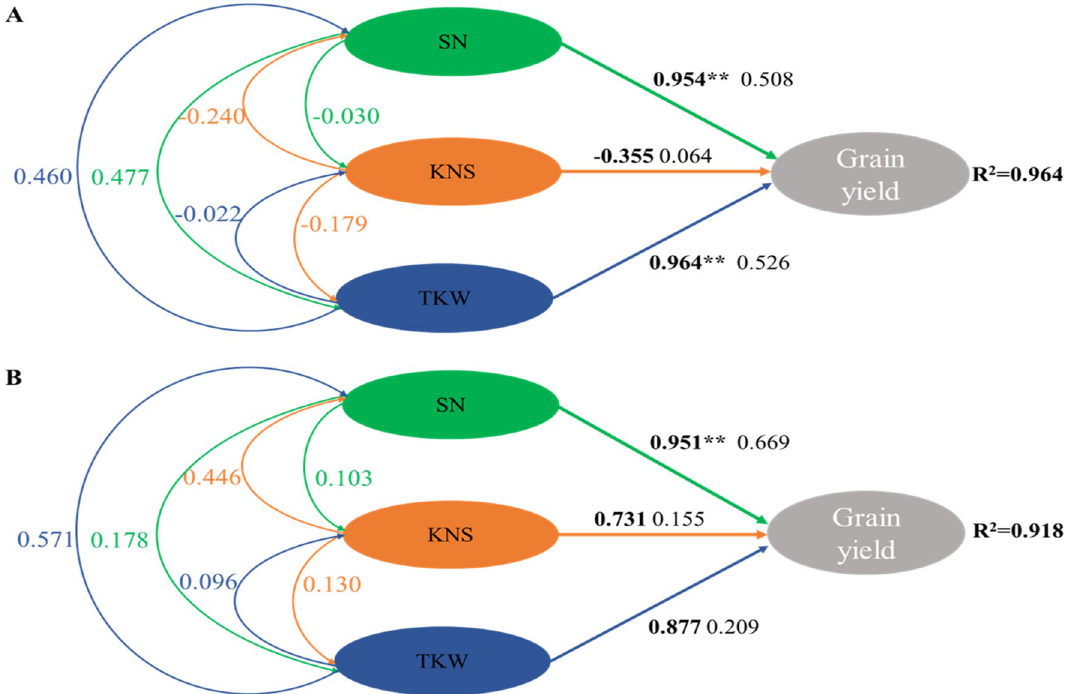
Figure 8. Overall path analysis of yield components for wheat ( A ) and maize ( B ) grain yield with thick lines represent direct pathways and fine lines represent indirect pathways. Values in bold are the correlation coefficient and fine values are the path coefficient. * P ≤ 0.05, ** P ≤ 0.01. SNE, KNS and TKW indicate the spike number, kernel number per spike, and thousand-kernel weight,